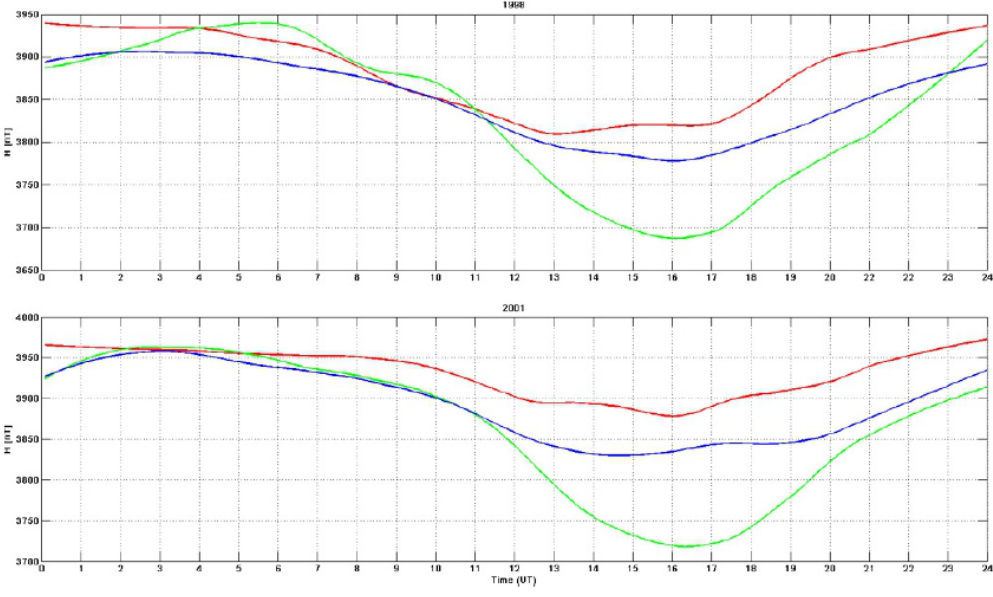
Fig. A2. Figure 5 of Janzhura and Troshichev (2011). The mean daily variation in H magnetic component at station Thule derived for three gradations of the IMF azimuthal component B y > 3nT (red line), B y < − 3nT (green line) and − 2 < B y < 2nT (blue line) for the summer months (May–August) of 1998 and 2001.